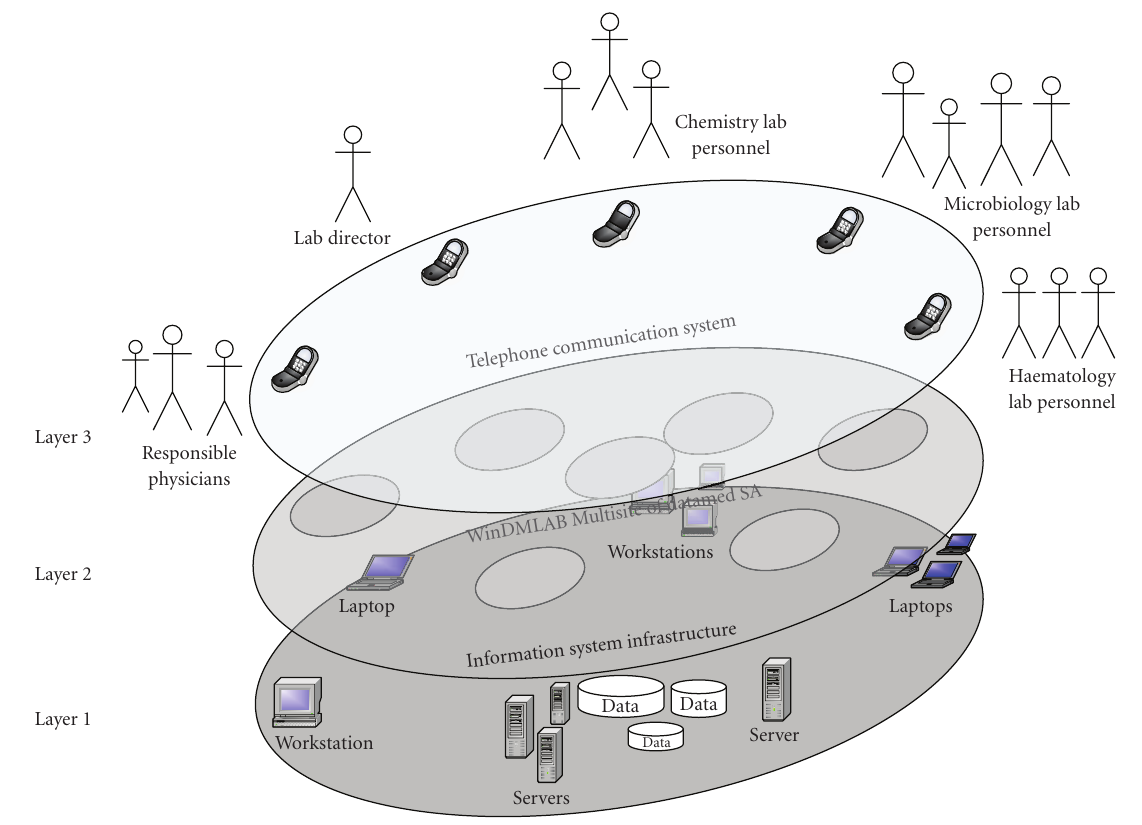
Figure 1: Layers of the current laboratory information